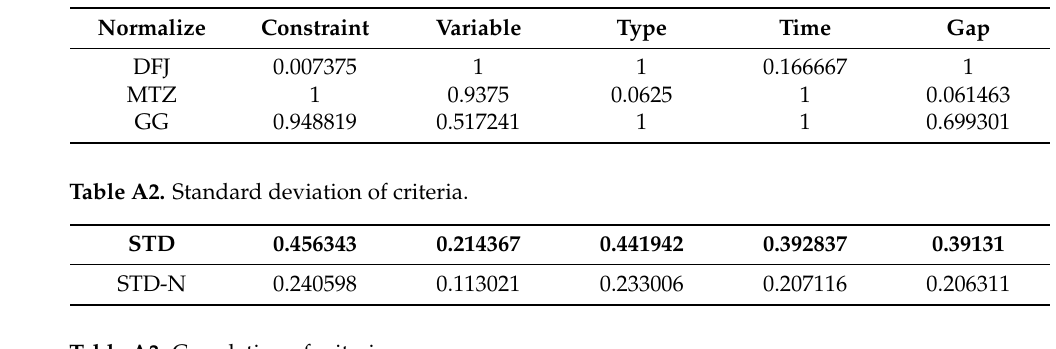
Table A3. Correlation of criteria.